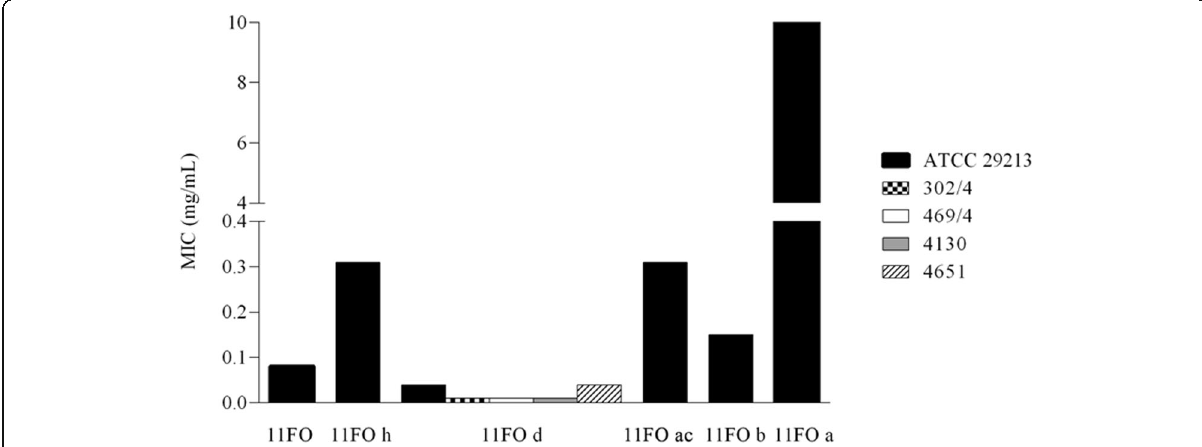
Fig. 1 Determination of MICs for the 11FO fractions. 11FO h (hexane), 11FO d (dichloromethane), 11FO ac (ethyl acetate), 11FO b (n-butanol), and 11FO a (water) were evaluated on Staphylococcus aureus ATCC 29213, 302/4, 469/4, 4130, and